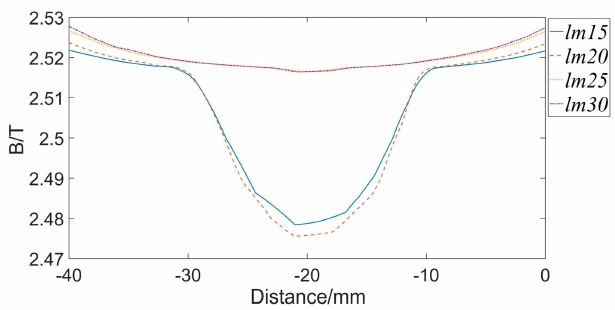
Figure 5. Magnetic flux density of wire ropes with di ff erent magnet lengths.